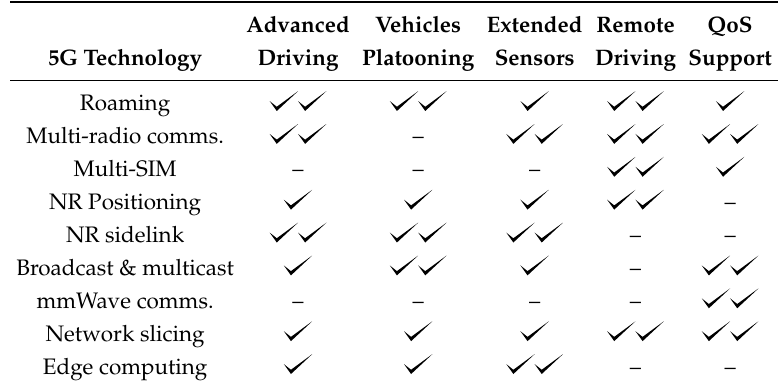
Table 4. A qualitative assessment of the relevance of communication technology to support use cases in cross-border contexts.